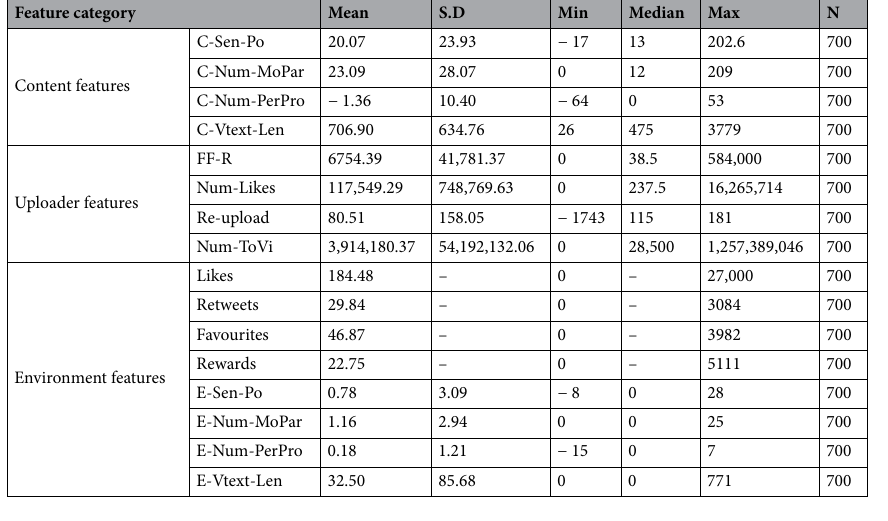
Table 1. Features of the misleading video